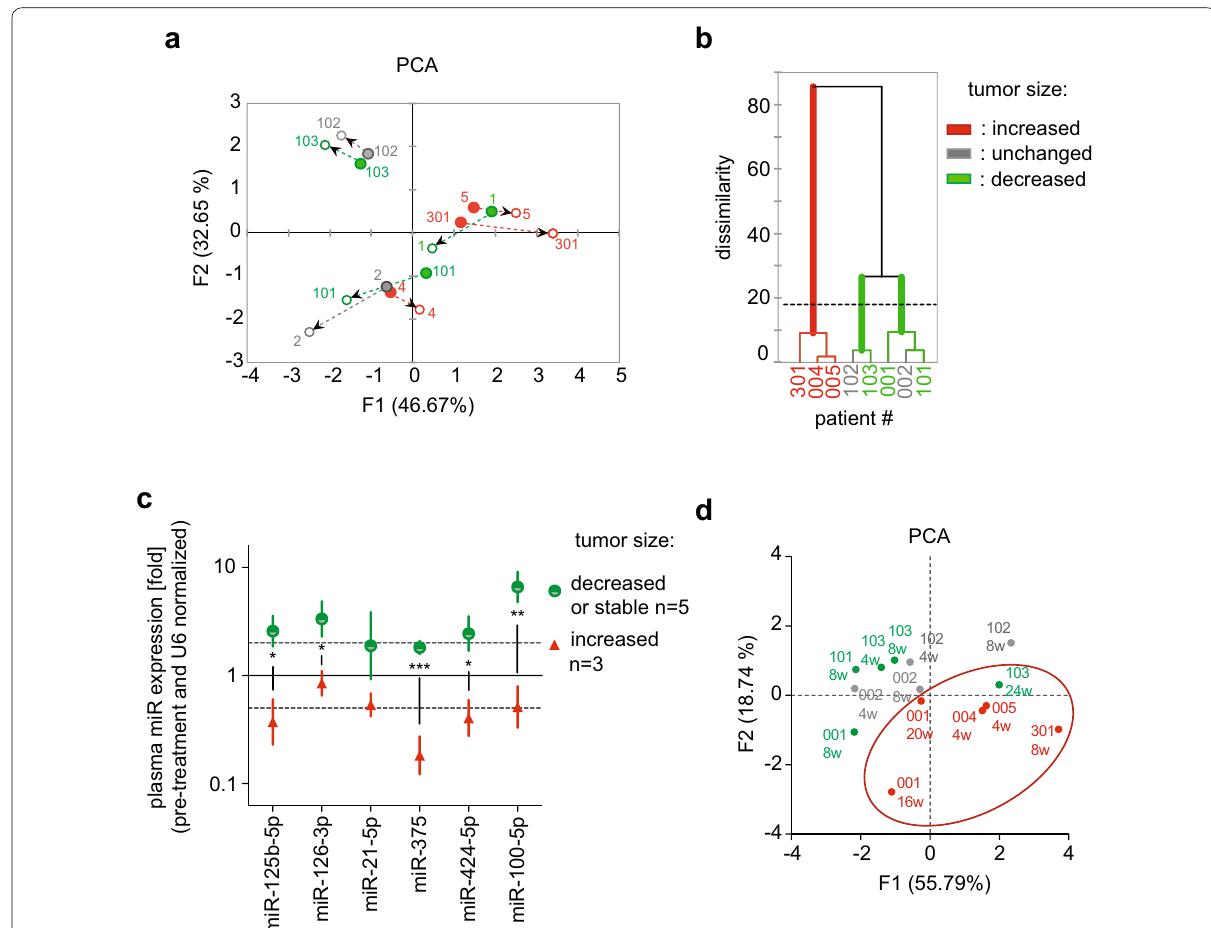
Fig. 3 Expression patterns of circulating miRs separate patients based on the response to dovitinib treatment. a Principal component analysis of the expression of six miRs before treatment (closed circles) and after treatment (open circles): patients 001, 002, 004, 005, 102, 103: 4 weeks; patients 101, 301: 8 weeks. The arrows indicate the before-to-after direction of the change. Patients that are separated by color code to indicate changes in tumor sizes after 8 weeks treatment (red increase, green decrease, grey no change). b Cluster analysis of the miR expression changes after = = = 4 or 8 weeks treatment with dovitinib. The dashed line indicates significant differences (Euclidian distance) between 3 patient groups. c Changes in six circulating miRs early after dovitinib treatment (4 weeks, except patient 101 and 103 at 8 weeks) based on tumor responses. The fold change in expression after treatment relative to U6 is indicated. Error bars SEM, *p < 0.05; **p 0.0032; ***p 0.0006 by unpaired t-test. d Principal = = = Component Analysis of the changes in expression of six miRs after dovitinib at multiple time points. The red circle includes patients with dovitinib resistant tumors. Patient 103 at 24 weeks is the exception in this